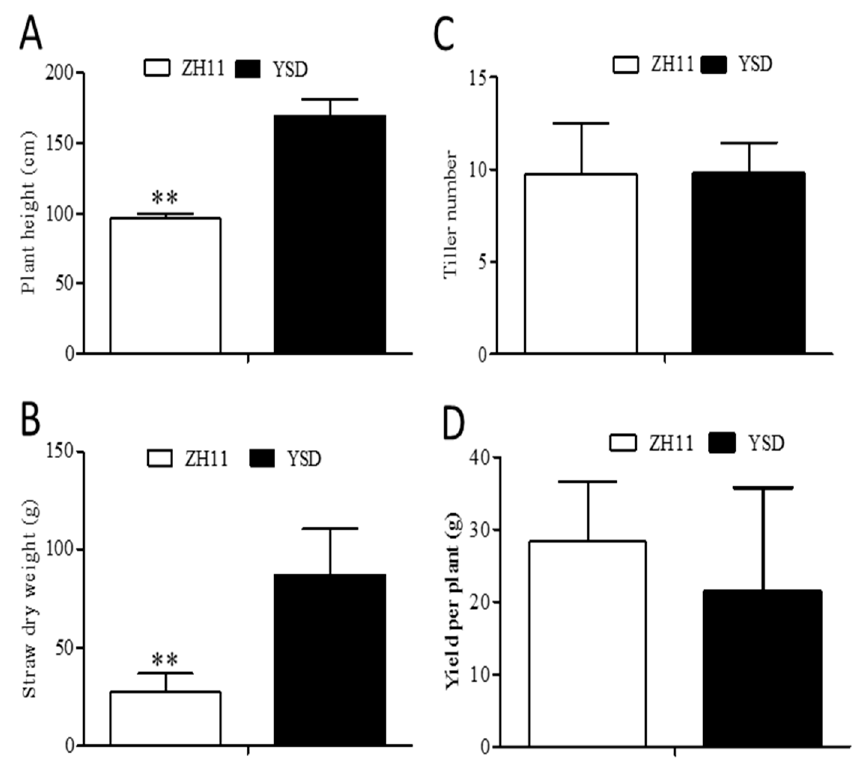
Figure 7. Analysis of agronomic characters of YSD and ZH11. Measurement of rice height ( A ), straw dry weight ( B ), tiller number ( C ) and yield per plant ( D ) at harvest stage. Data are presented as the means (±SD), n = 10. Significant differences were determined using the Student’s t -test: ** p < 0.01.